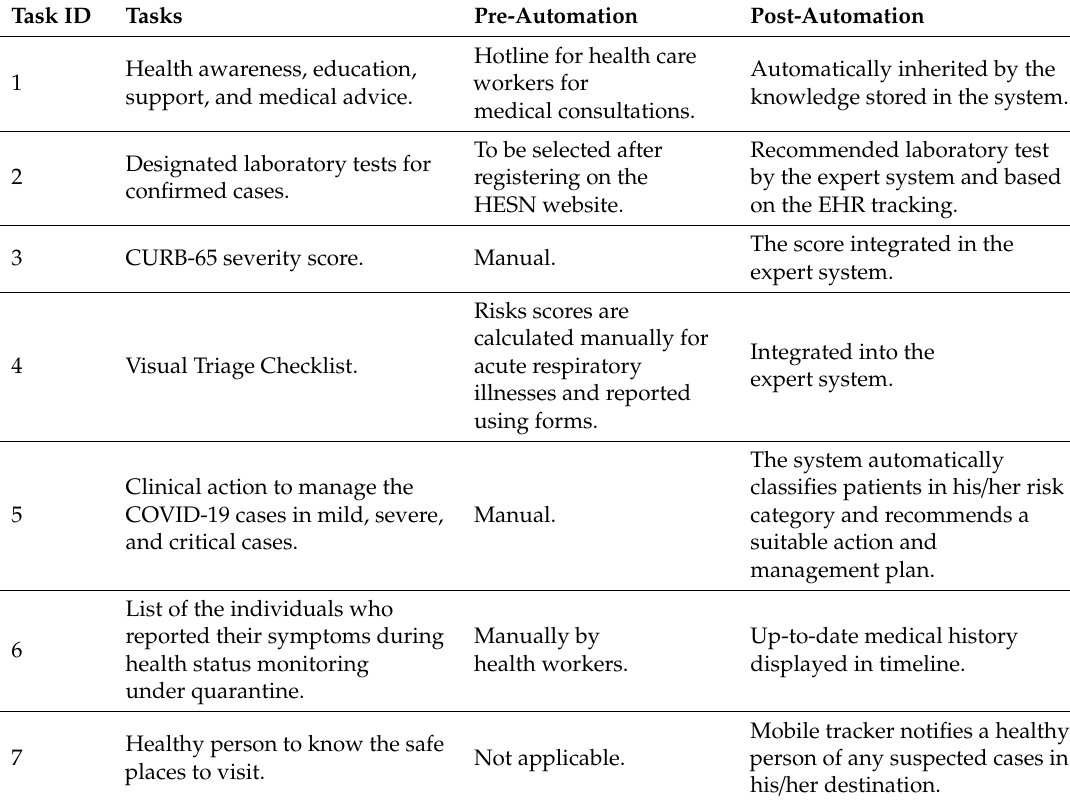
Table 1. Tasks comparison between pre-automation and